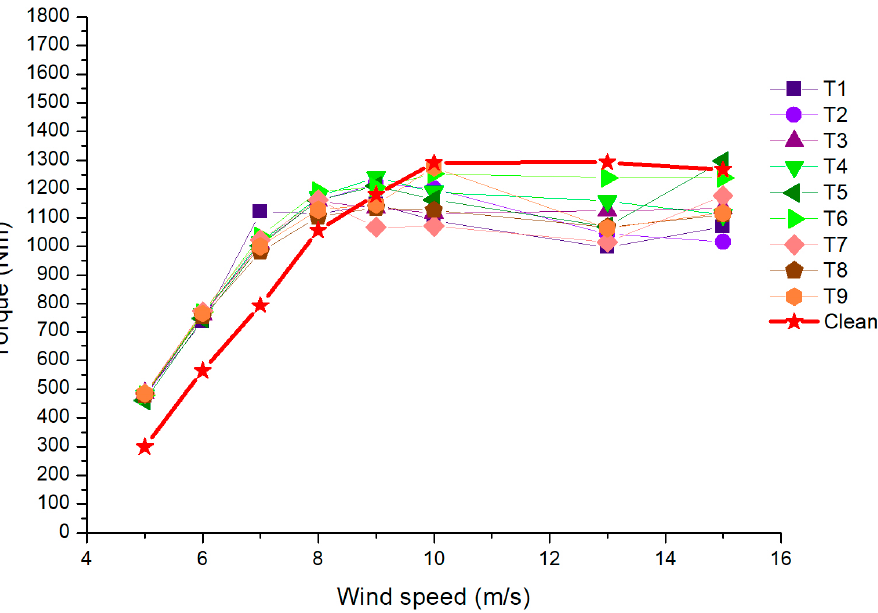
Figure 7. Torque comparison of cases T1, T2, T3, T4, T5, T6, T7, T8 and T9 with the experimental results of the clean blade .